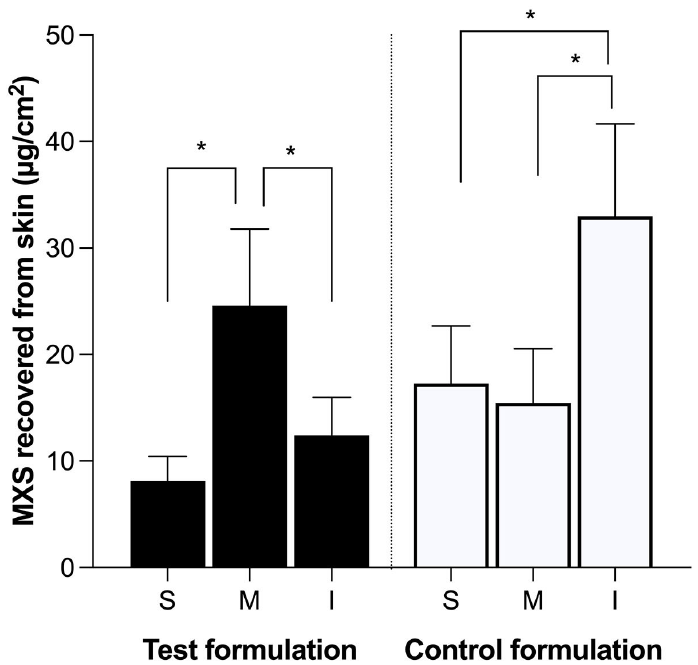
Figure 3. Amount penetrated in µ g/cm 2 of MXS in total skin in the vertical penetration test after 12 h from test formulation (PLX 16% HPMC 0.4%) and control formulation (PLX 4% HPMC 0.7%), both containing 2% MXS. Portions of the total skin represented by: S: superior; M: medium; I: inferior. Statistical analysis using two-way ANOVA with multiple comparisons ( p < 0.05). * = significant difference. Data were expressed as mean ± SD of 6 replicates for each formulation.